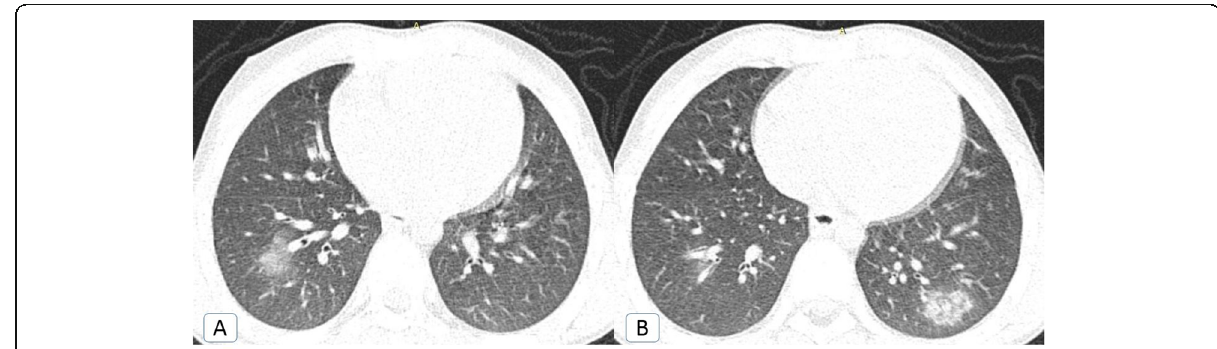
Fig. 1 Typical COVID-19 CT signs in a 7-year-old boy: A , B Axial chest CT cuts (lung window) showing bilateral lower lobar ground glass patches with evolving left basal consolidative